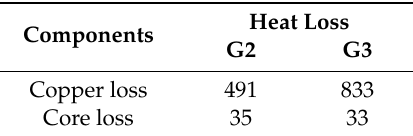
Figure 12. Temperature distribution of G2 for various ambient conditions ( − 40 °C, +30 °C, +65 °C).